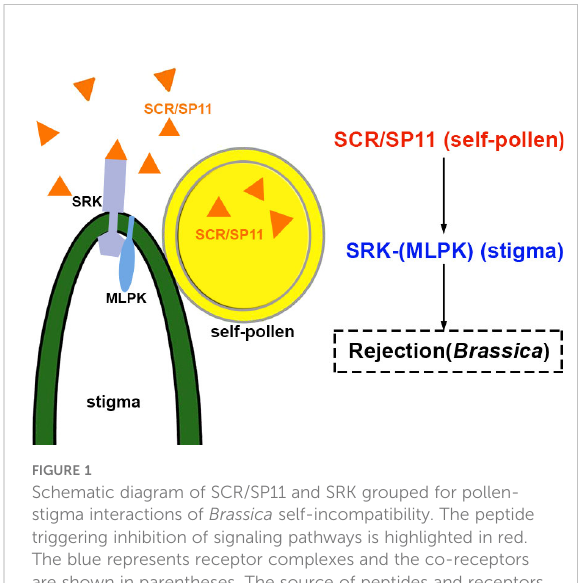
FIGURE 1 Schematic diagram of SCR/SP11 and SRK grouped for pollen- stigma interactions of Brassica self-incompatibility. The peptide triggering inhibition of signaling pathways is highlighted in red. The blue represents receptor complexes and the co-receptors are shown in parentheses. The source of peptides and receptors is shown in parentheses. Abbreviations for all small peptides and receptors are elucidated in the